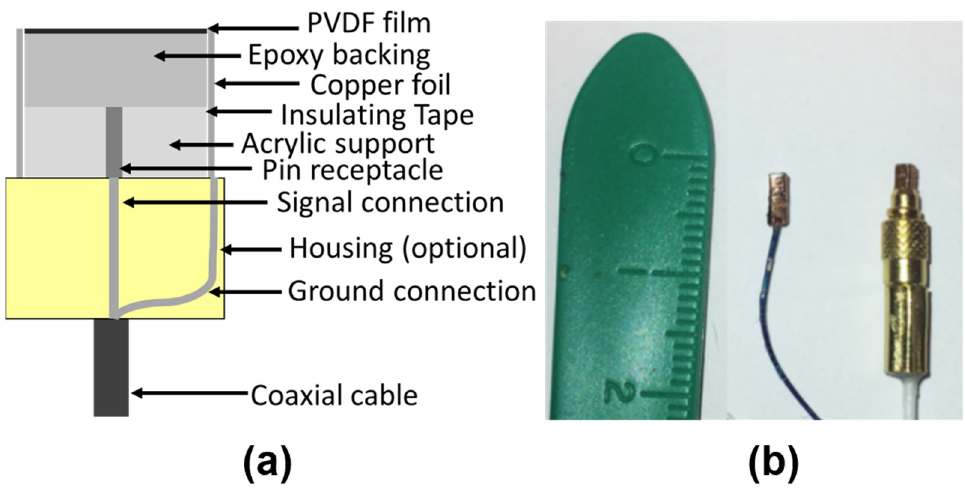
Figure 1. Schematic of the device ( a ) and fabricated receivers ( b ) with or without a standard MMCX connector as housing. A receiver without housing was connected to a micro coaxial cable.